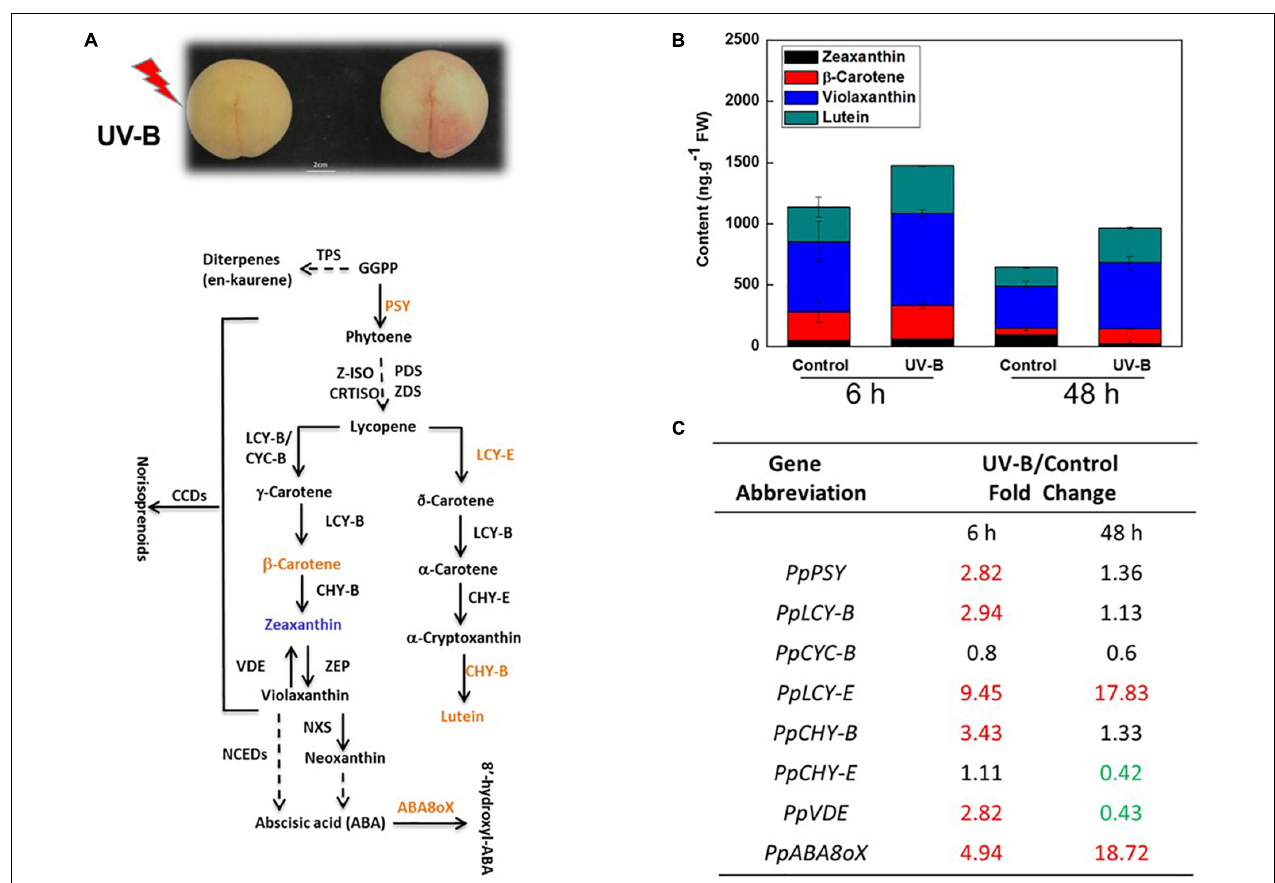
FIGURE 3 | Carotenoids content and transcript level of genes regulated under UV-B irradiation. (A) The schematic map of carotenoids metabolic pathways. (B) Change of the carotenoids content. (C) Fold changes of the related genes transcript levels between UV-B and the control. The red color numbers mean the significant induction, and the green color mean the significant inhibition under UV-B irradiation with p <